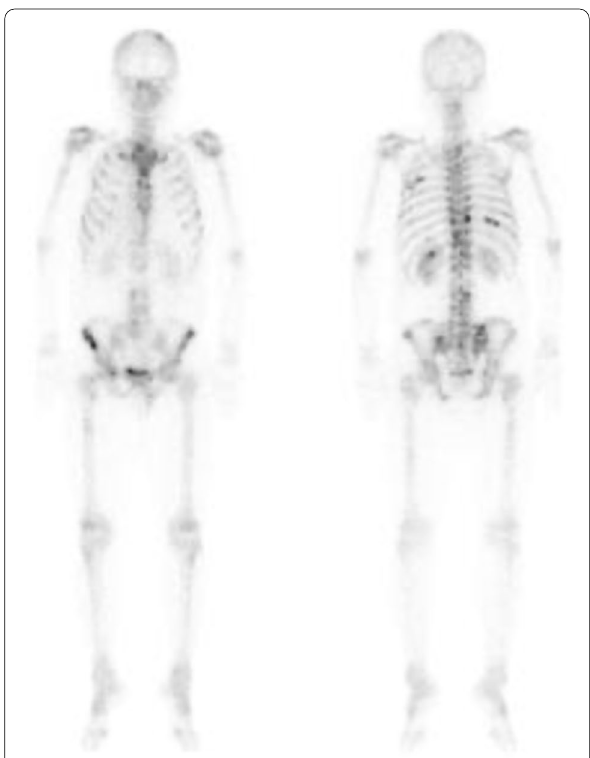
Fig. 4 Bone scintigraphy revealed multiple hot spots throughout most of the spine, pelvis, and